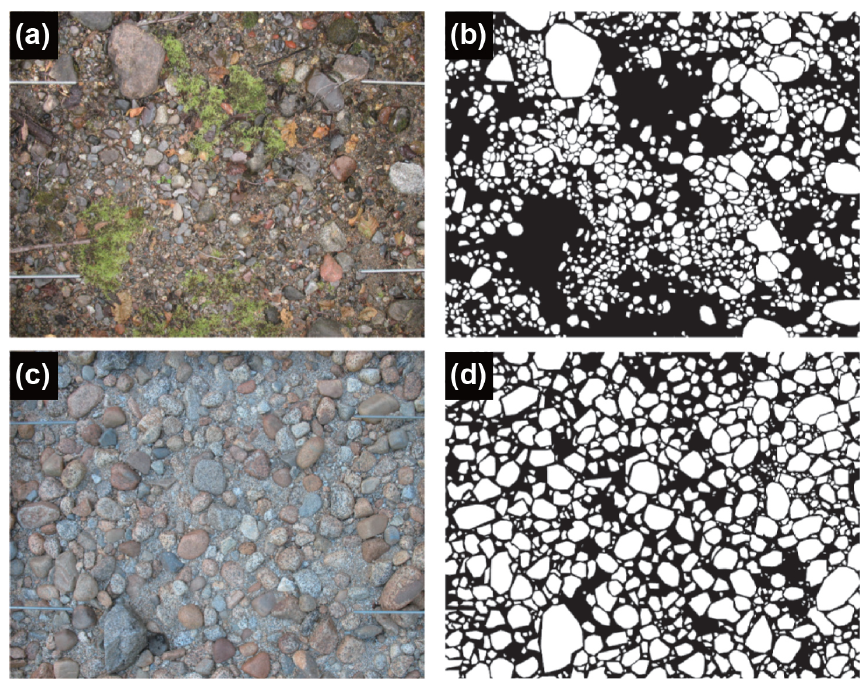
Figure 2. Examples of two field photos and the corresponding manual labels: (a) photo with vegetation from Anderson Creek and (b) the corresponding manual label; (c) photo without vegetation from Coquitlam River and (d) the corresponding manual label.